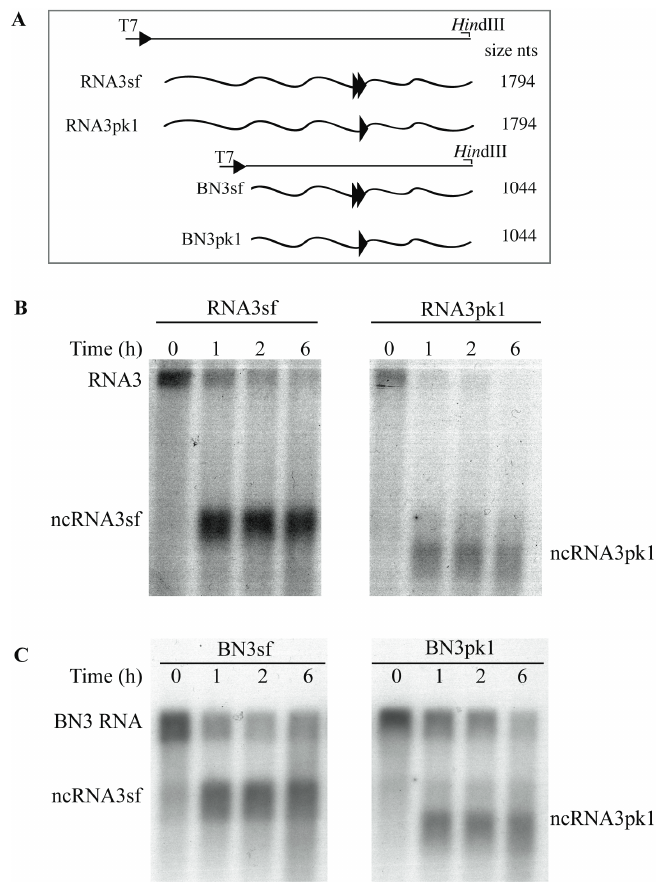
Figure 3. Both ncRNA3sf and ncRNA3pk1 stall Xrn1 processing in vitro. ( A ) Schematic representation of the T7-driven cDNA clones constructs used to produce run-off in vitro transcripts depicted in waved lines. Double and single arrowheads correspond to the sf and pk1 structural motifs, respectively. The position of the restriction sites used and the size of the transcripts are indicated; ( B ) 5 ′ phosphorylated chimeric RNA3sf or RNA3pk1 and ( C ) BN3sf or BN3pk1 species were mixed with commercial Xrn1 enzyme for 6 h. Aliquots were sampled at the time indicated and RNAs species were detected by northern blot using a specific DNA probe able to reveal both full-length and ncRNA3 species.